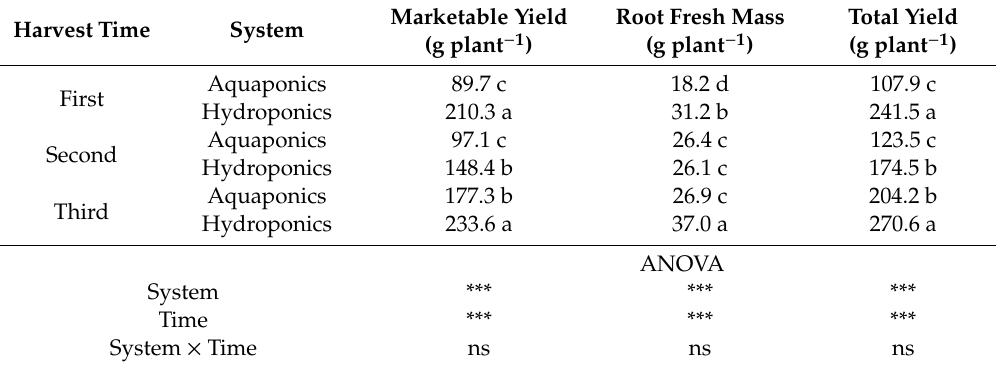
Figure 3. The number of flowers and tomato fruit harvest in aquaponics and hydroponics over a 3-month production period. Each data point is the mean of 8 replicates. Table 6. Yields of lettuce in aquaponics and hydroponics at three harvest times.